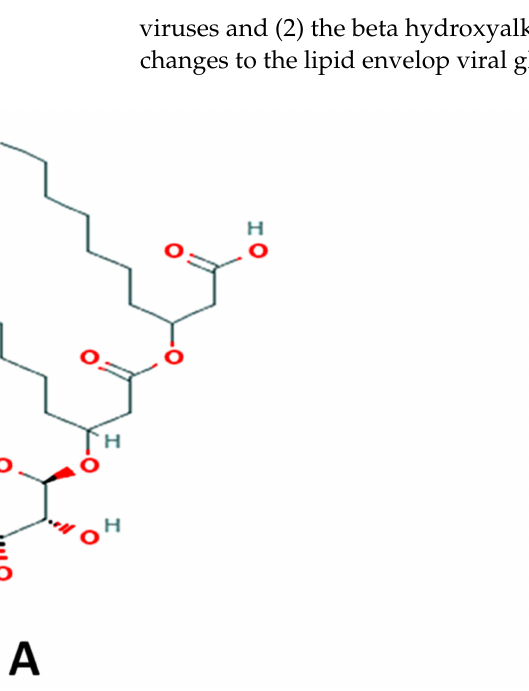
Figure 1. Chemical structure of ( A ) rhamnolipids R1 (mono-rhamnolipids; Rha(s)1) and ( B ) rhamnolipids R2 (di- rhamnolipids; Rha(s)2). Chemical structures were retrieved from PubChem; https://pubchem.ncbi.nlm.nih.gov (accessed on 16 June